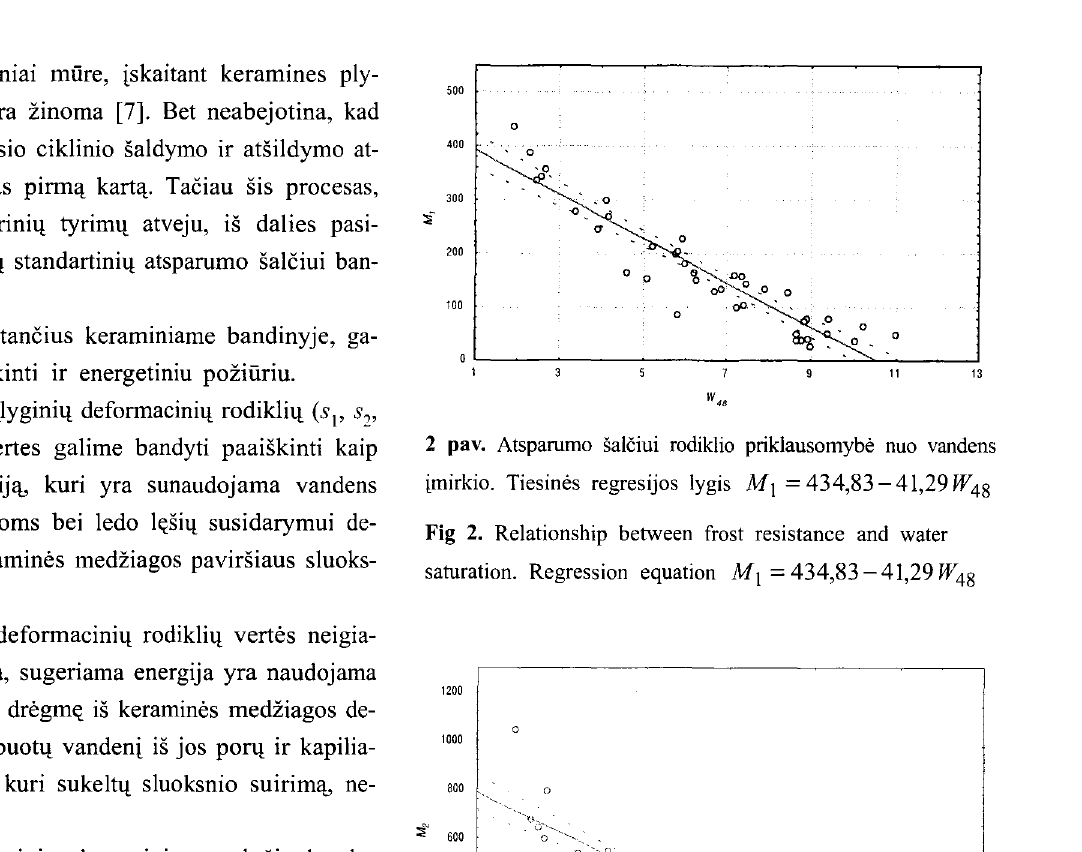
s = 872,52-83,59 W 2 4